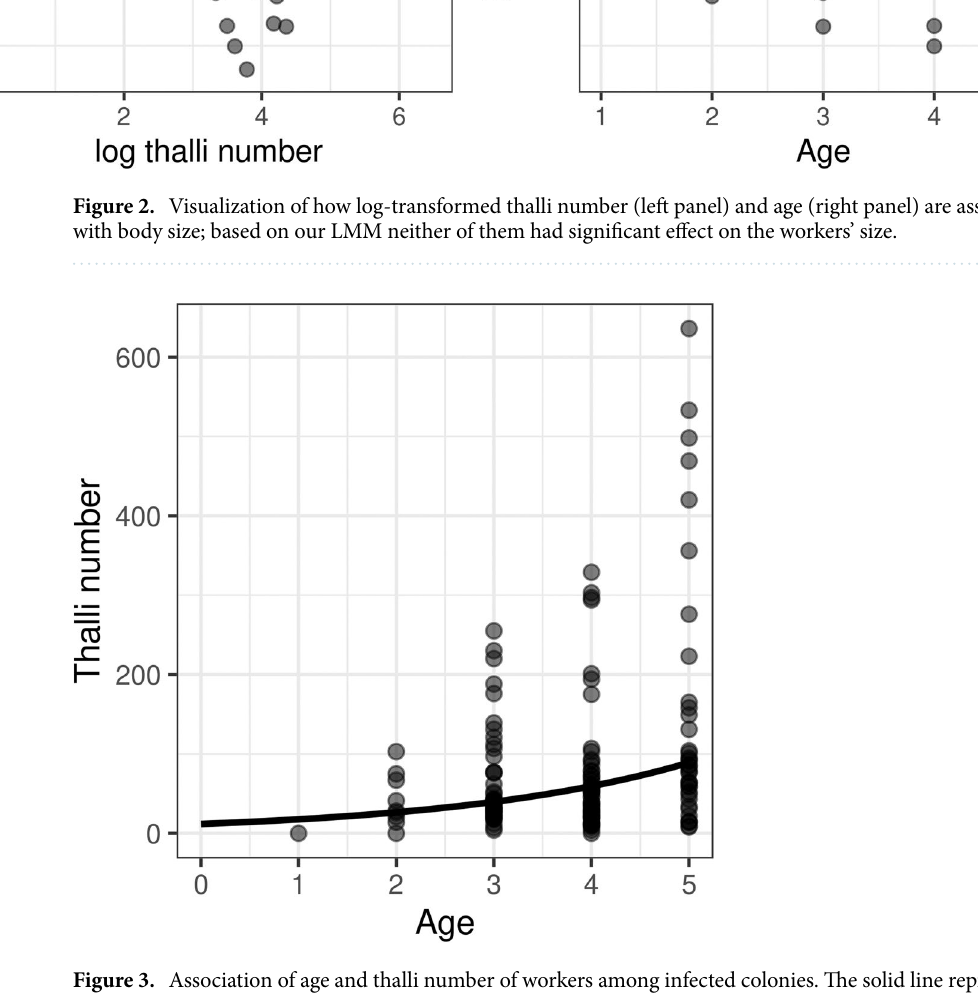
Figure 3. Association of age and thalli number of workers among infected colonies. The solid line represents the association predicted on the Poisson